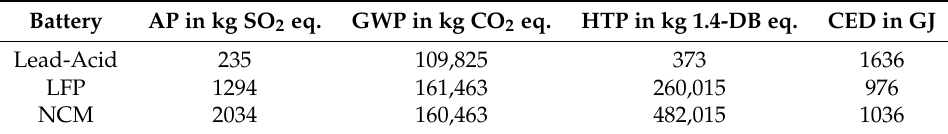
Table 10. LCA for different battery systems per MWh storage